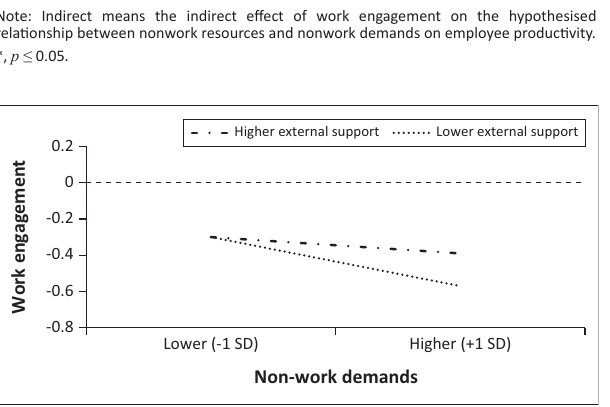
FIGURE 2: Interactive effects of higher (vs. lower) external support on the relationship between nonwork demands and work